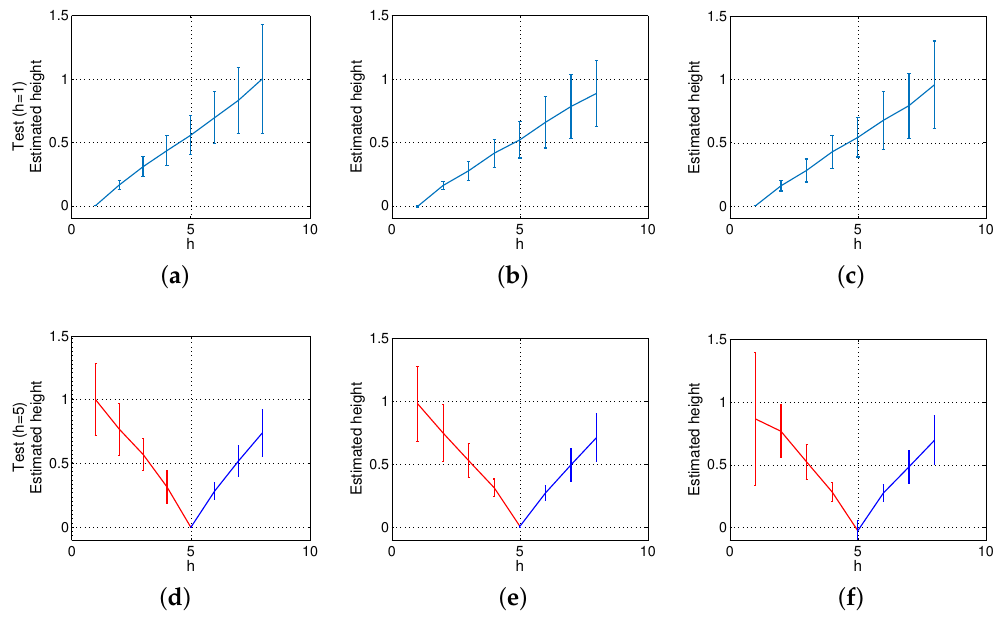
Figure 19. Altitude estimation using the method based on ASIFT and the indoors dataset. Reference images at the bottom (h = 1) and ( a ) original test images, ( b ) noise added to the test images, and ( c ) occlusions added to the test images. Reference in the middle of the height (h = 5) and ( d ) original test images, ( e ) noise added to the test images, and ( f ) occlusions added to the test